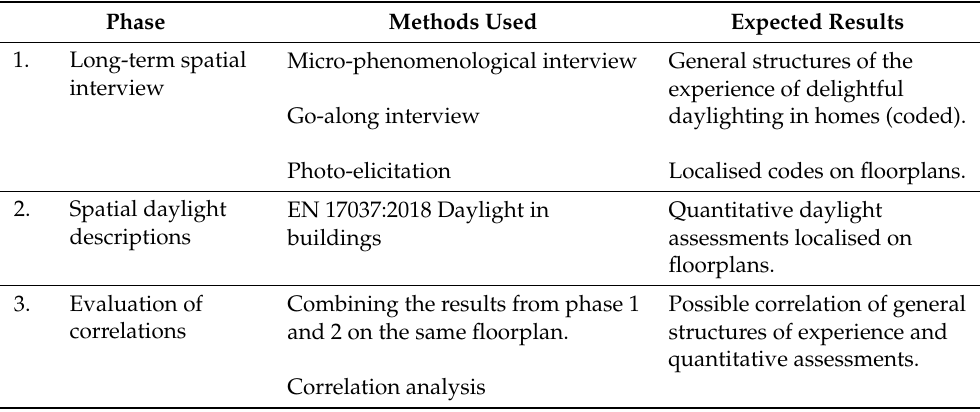
Table 1. The three main phases of the framework combine existing methods in a novel